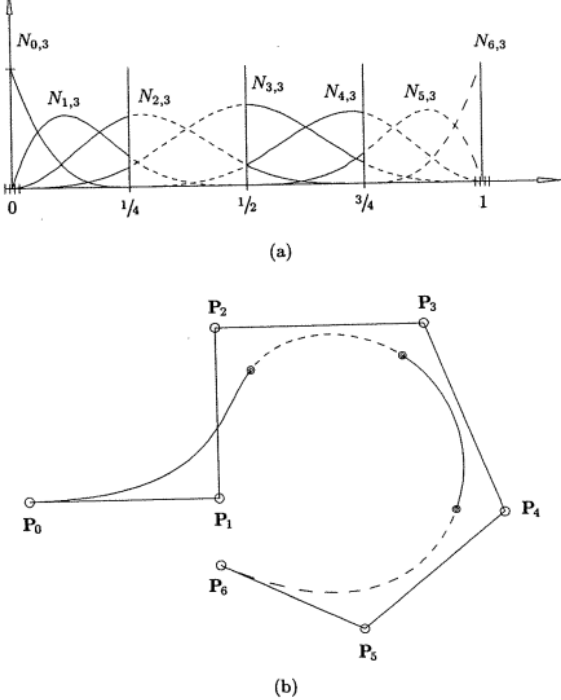
Figure 6. ( b ) Cubic B-spline curve and related basis functions ( a ).